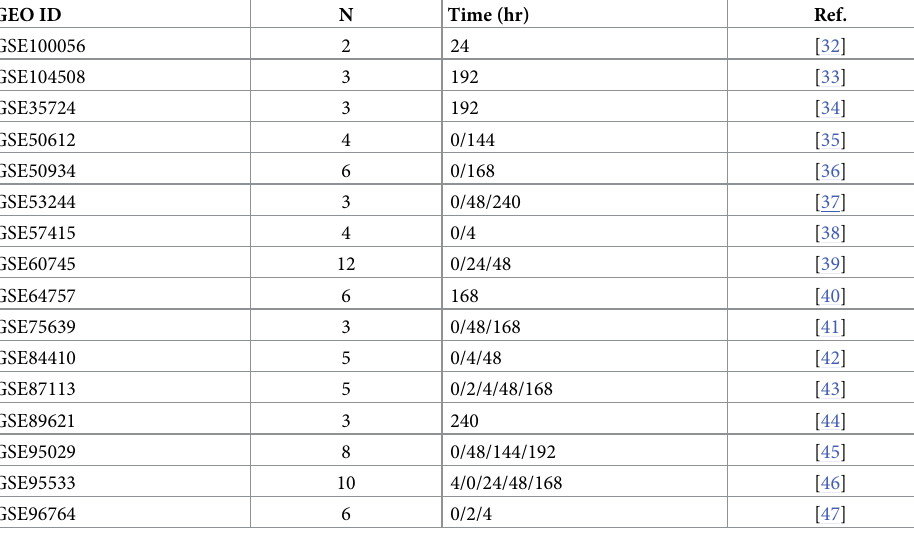
Table 1. MDI-induced 3T3-L1 gene expression data by RNA-seq. GEO ID